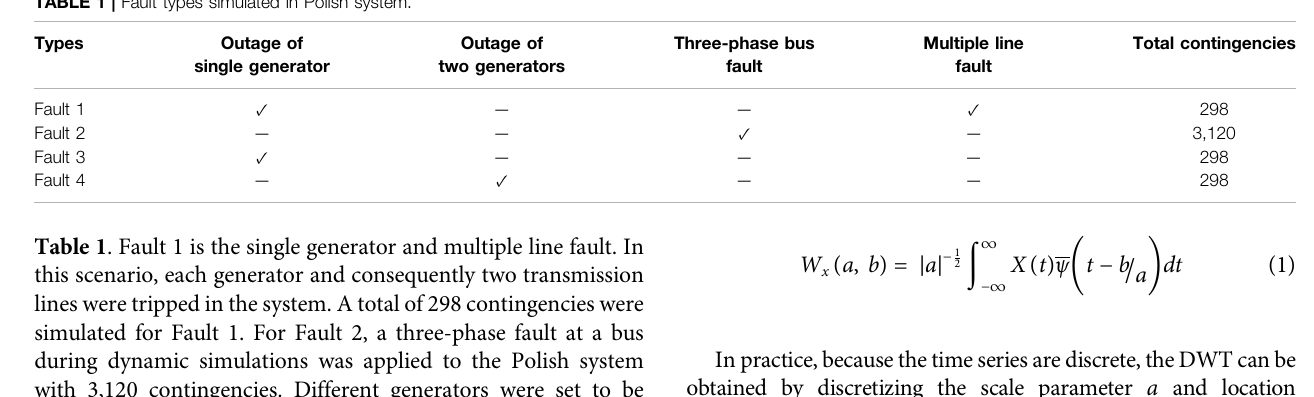
TABLE 1 | Fault types simulated in Polish